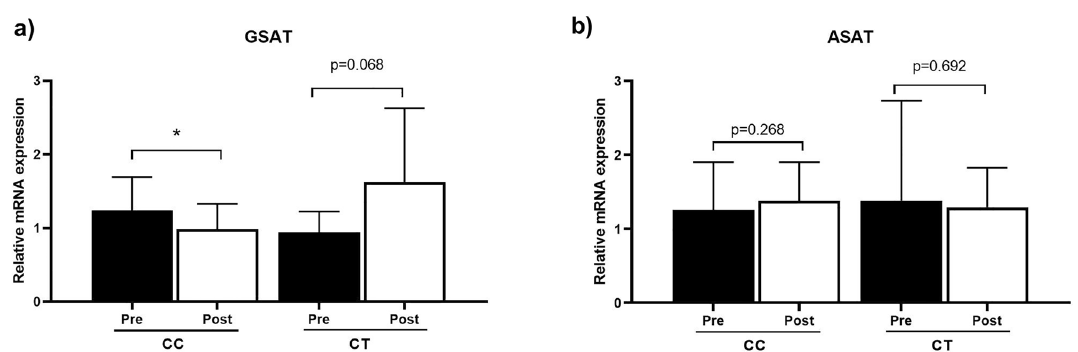
Figure 4. Relative mRNA expression of FKBP5 in gluteal adipose tissue (GSAT) ( a ) and abdominal subcutaneous tissue (ASAT) ( b ) pre- and post-exercise training intervention and stratified by the rs1360780 genotype. Data represented as mean ± SD. * p < 0.05. (n = 19, CC n = 11, CT n =